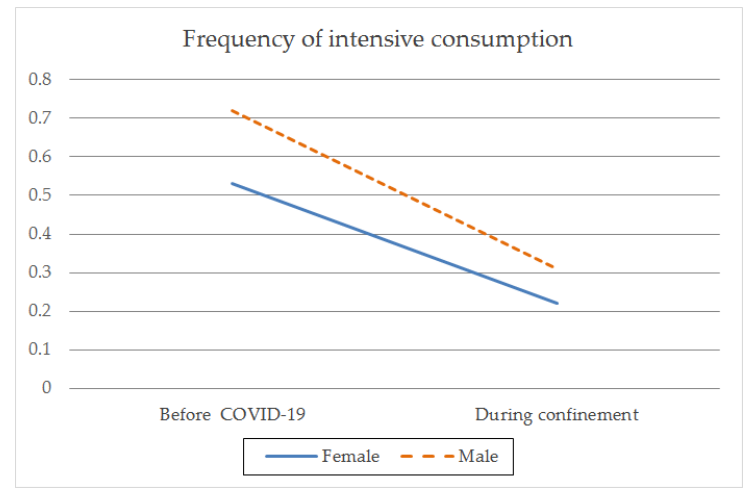
Figure 3. Frequency of intensive alcohol consumption by gender before the pandemic and during confinement due to COVID-19.